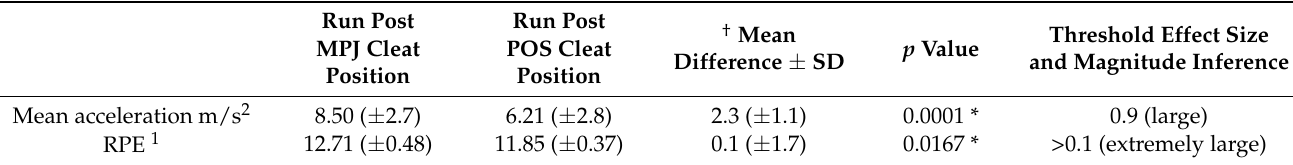
Table 4. Descriptive data (means ± SD) from individual 5 km laps of overground running after cycling in two cleat positions (in m/s 2 ). 1 RPE = ratings of perceived exertion. 2 Diff = difference between MPJ and POS cleat positions.